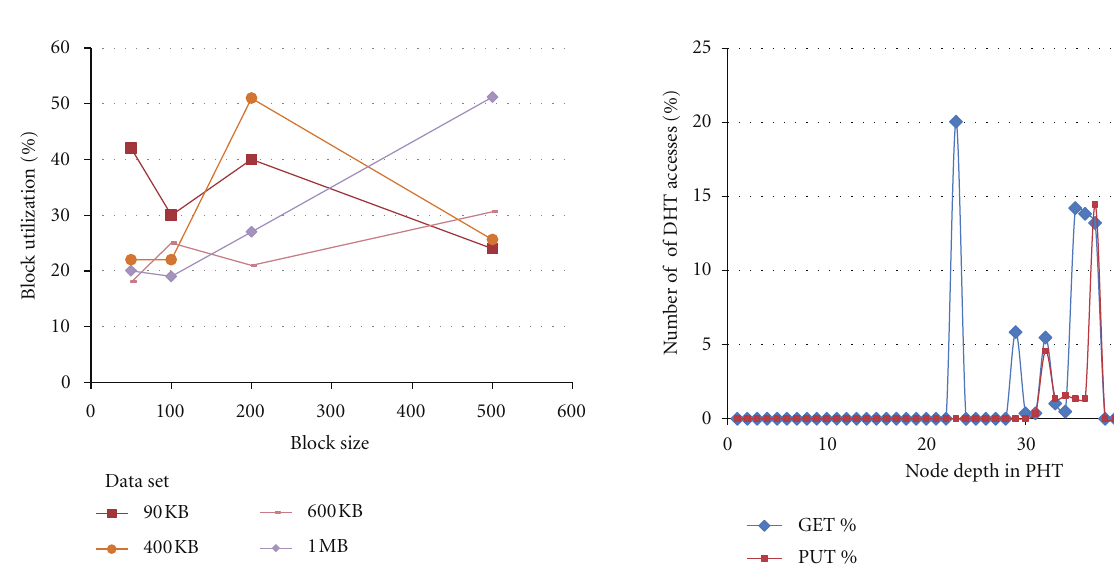
Figure 8: Number of accesses to the DHT against node depth in the PHT for the insert